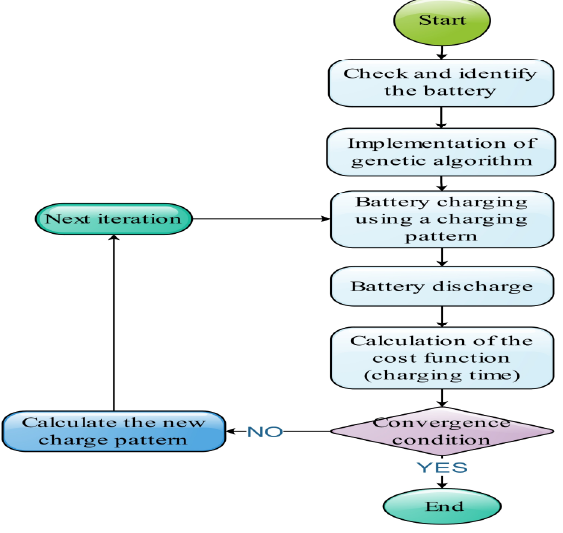
Figure 10. Proposed charge management flowchart based on a genetic algorithm.